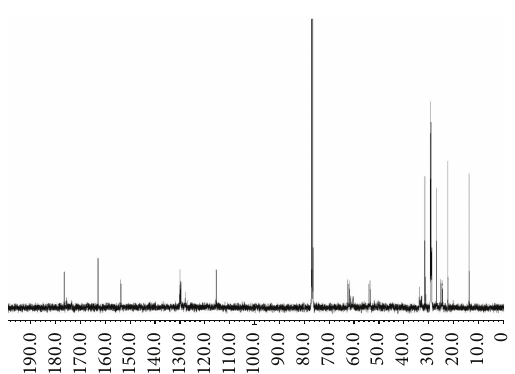
Figure 4: 13 C NMR spectra of PEAF.